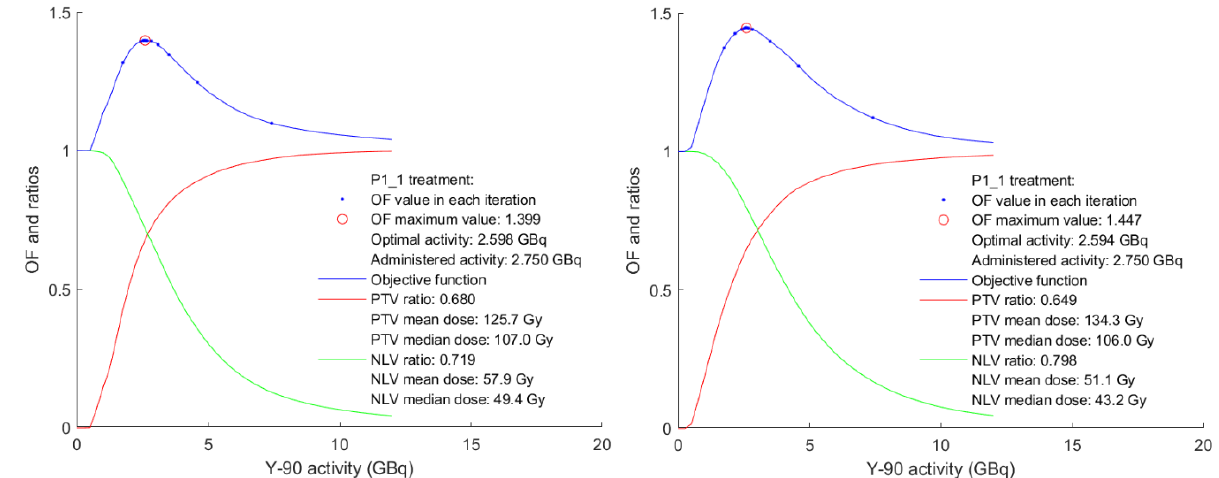
Figure 6. P1_1 optimization based on the SPECT-MAA ( left ) and PET-MS ( right ). The optimized OF and its two components are shown in blue, red (PTV ratio), and green (NLV ratio), respectively. The blue dots represent the OF values in each iteration during optimization.